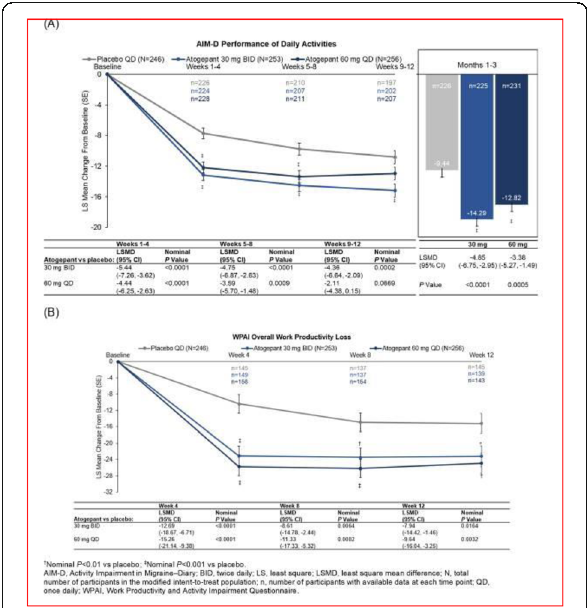
Fig. 1 (abstract P143). Change From Baseline in (A) AIM-D Performance of Daily Activities at Weeks 1-4, 5-8, and 9-12 and Across 12 Weeks and (B) WPAI Overall Work Productivity Loss at Weeks 1-4, 5-8, and